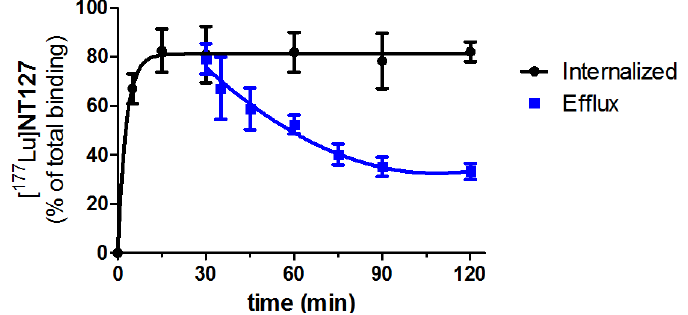
Figure 2. Internalization and efflux of [ 177 Lu] NT127 in human HT29 cells. Each data point represents the mean ± standard deviation of two experiments performed in quadruplicate.